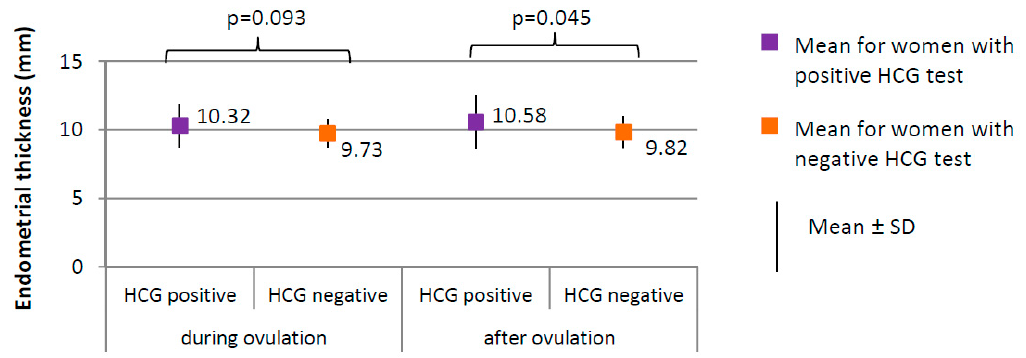
Figure 5. Comparison of endometrial thickness between women with positive HCG test ( N = 17) and women with negative HCG test ( N = 188).